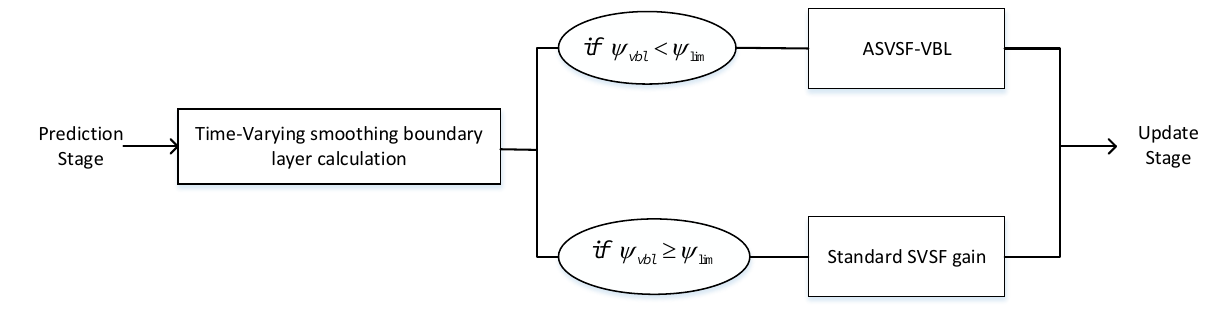
Figure 3. Overview of ASVSF-VBL